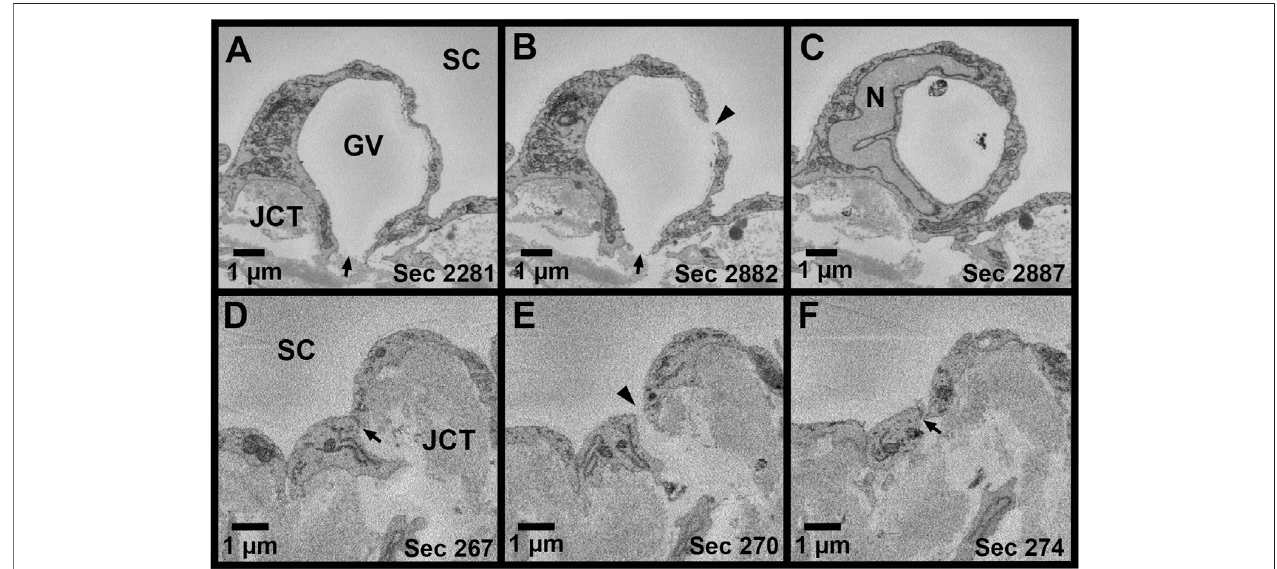
FIGURE1| Giantvacuoles and twotypes ofpores. (A – C) :Serialelectron micrographs showingagiant vacuole(GV) withanI-pore ( arrowhead ) and basalopening ( arrow ). (D – F) : Serial electron micrographs showing a B-pore ( arrowhead ) between two adjacent inner wall cells. The cellular junction can be seen before and after the B-pore ( arrow ). SC = Schlemm ’ s canal; JCT = juxtacanalicular connective tissue; N = inner wall endothelial cell nucleus; Sec = serial block-face electron microscopy section number.